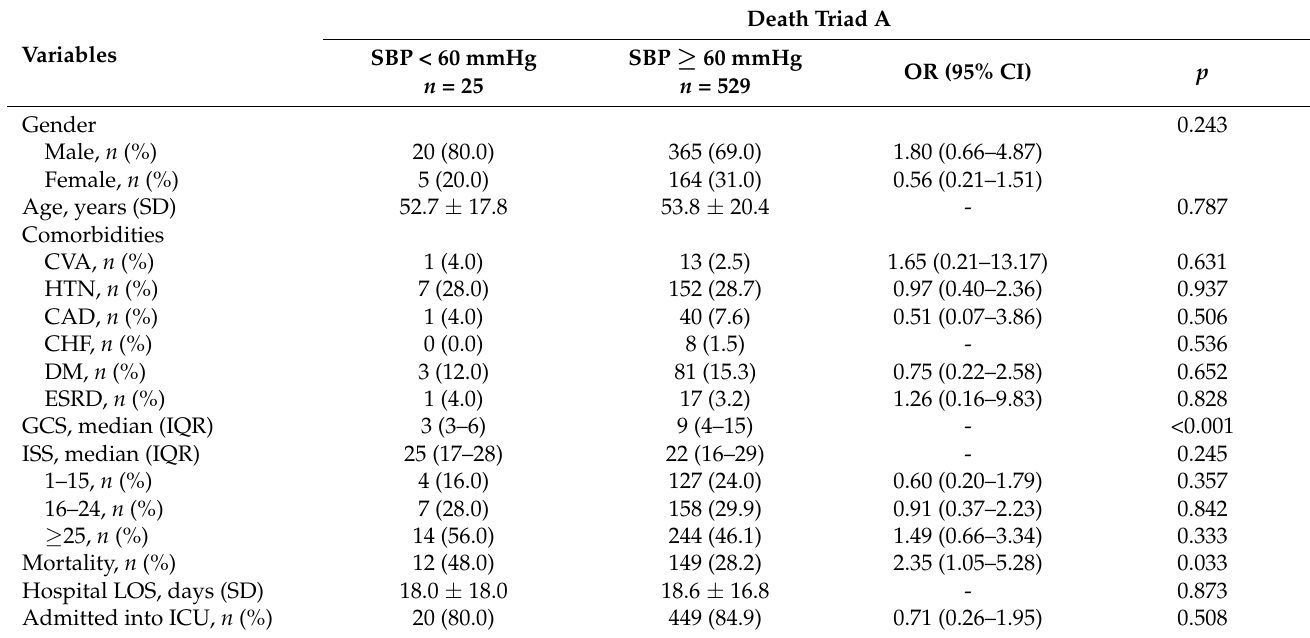
Table 2. The injury characteristics and outcome of trauma patients in death triad A with or without systolic blood pressure less than 60 mmHg.